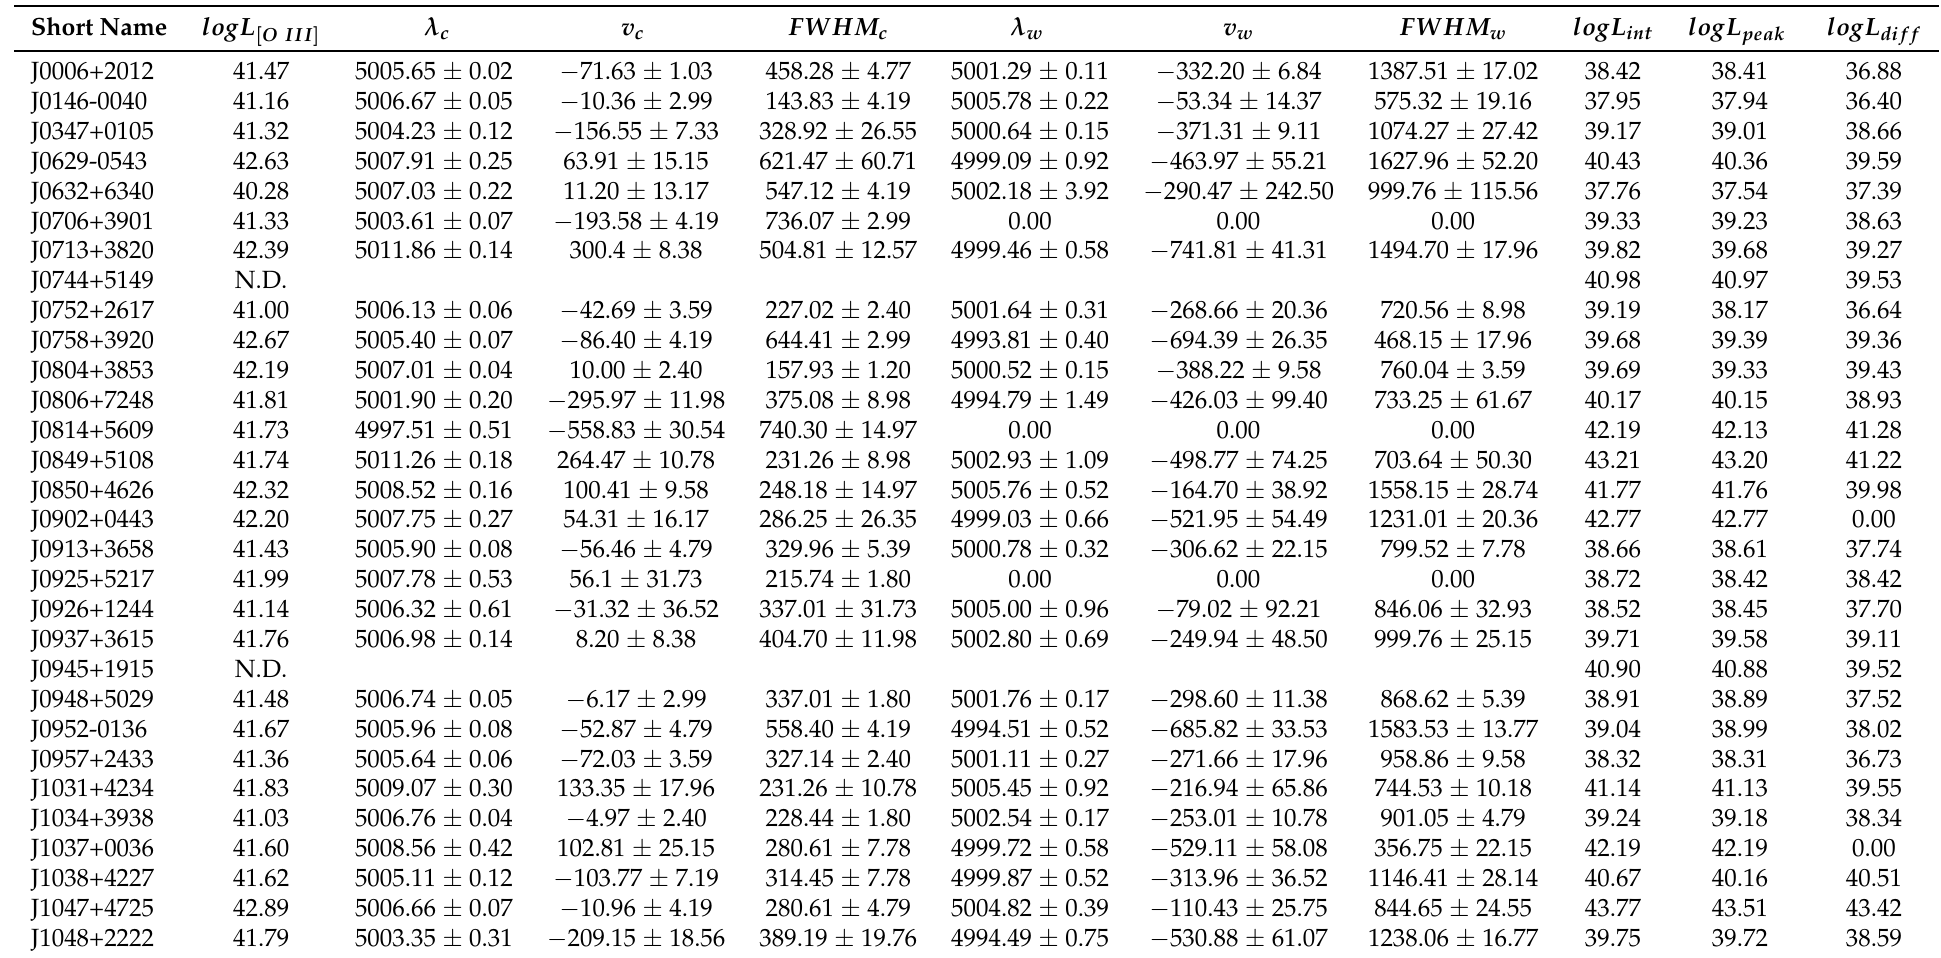
Table 2. [O III] and radio properties of the sample. Columns: (1) short name; (2) logarithm of the [O III] luminosity (erg s − 1 ); (3) wavelength of the [O III] core component (Å); (4) velocity of the [O III] core component (km s − 1 ); (5) FWHM of the [O III] core component (km s − 1 ); (6) wavelength of the [O III] wing component (Å); (7) velocity of the [O III] wing